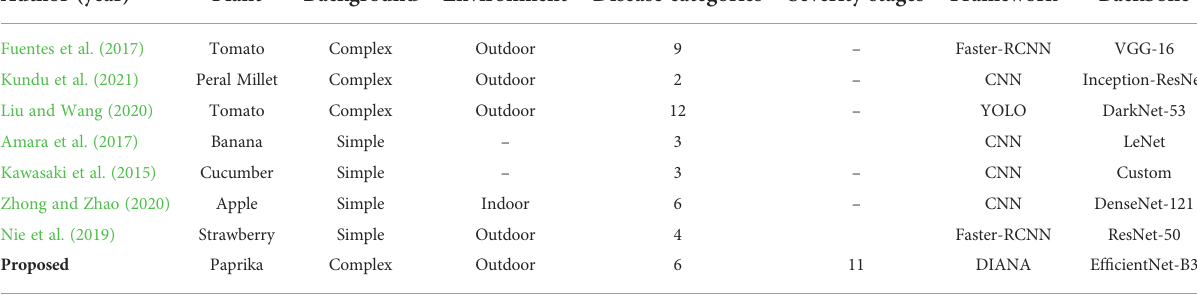
TABLE 1 Summary of a few datasets available in literature for plant disease